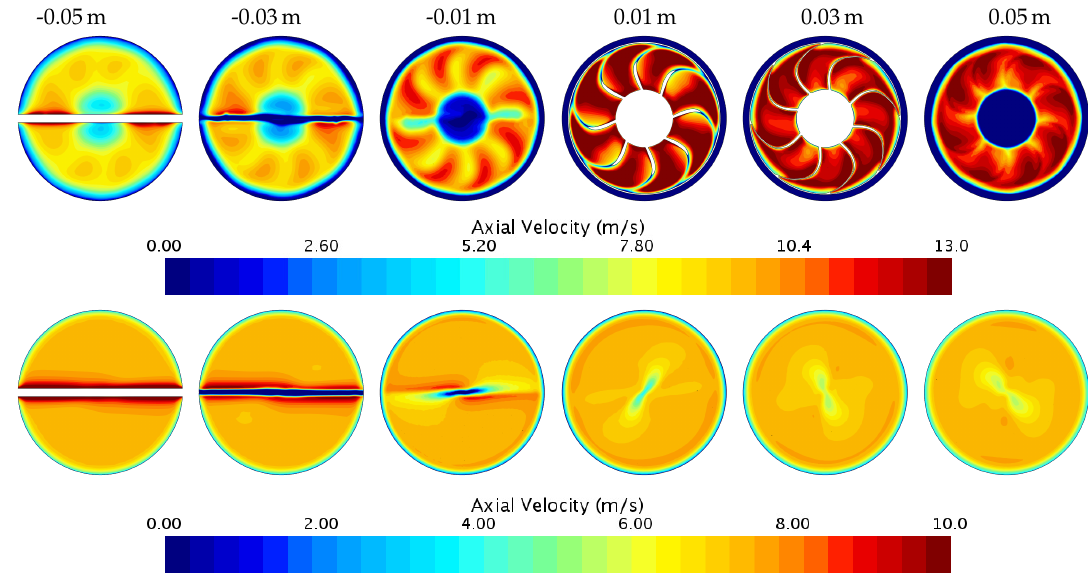
Figure 8. Influence of a cylinder placed upstream of the MRF region with ( upper row ) and without blades ( lower row ) on the axial velocity field from 0.05m upstream ( left ) to 0.05m downstream ( right ) of the